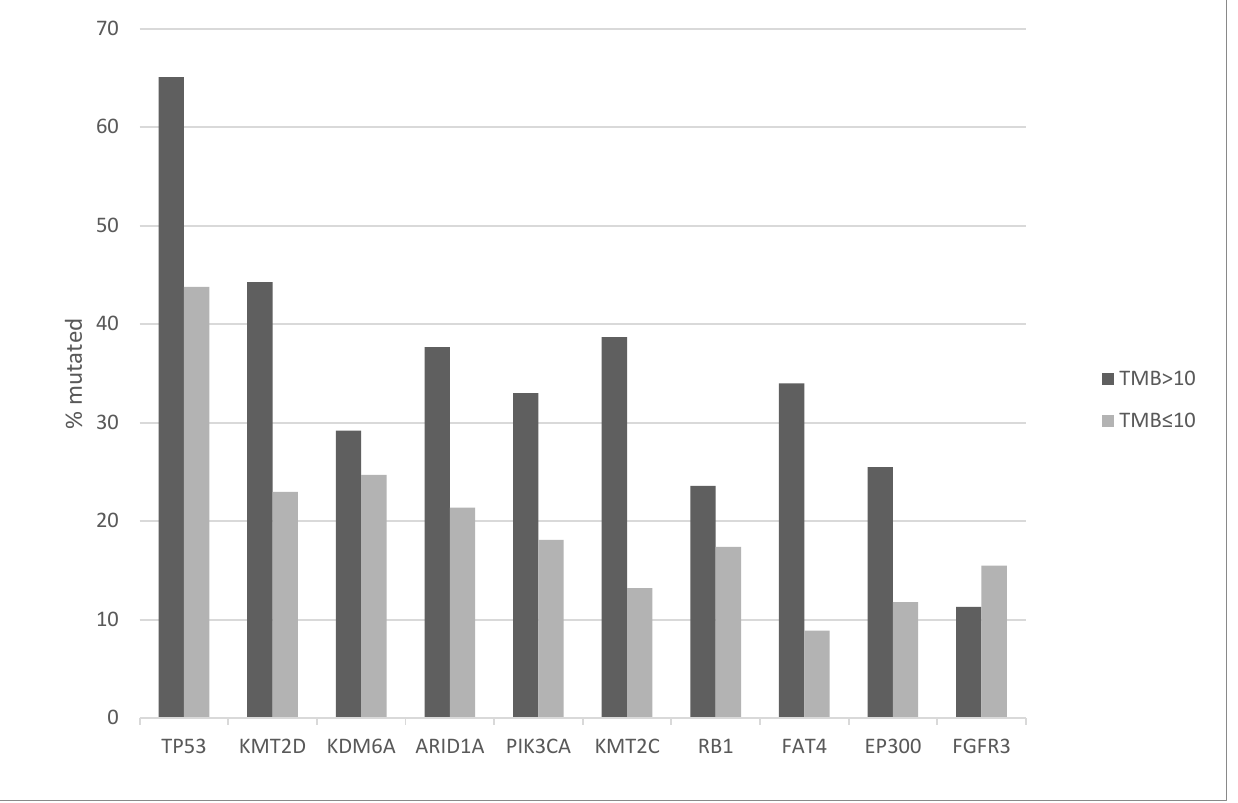
Figure 1. Prevalence of mutations in frequently mutated genes in bladder carcinomas according to TMB groups. High TMB group: TMB > 10 mutations/MB, low TMB group: TMB ≤ 10 mutation/MB. TMB: Tumor Mutation Burden.